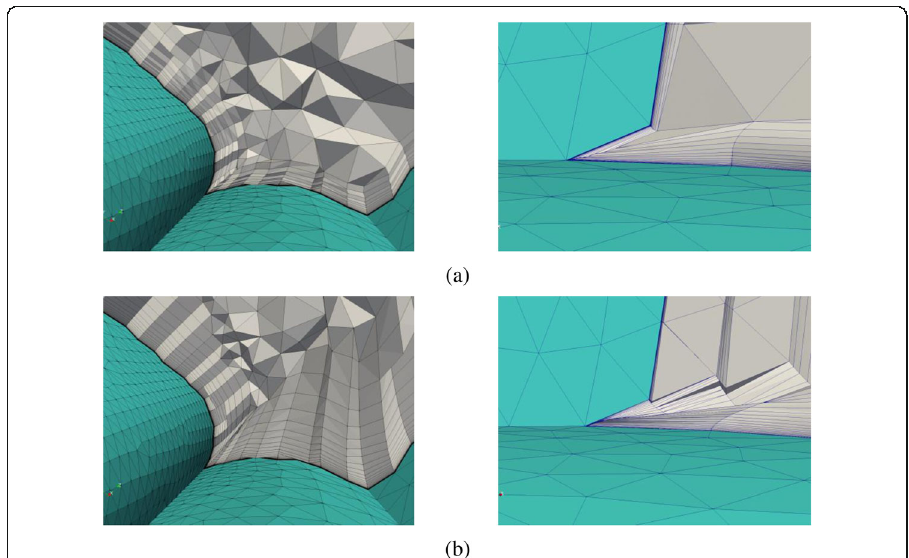
Fig. 13 Meshing results in the neighbourhood of two sharp concave angles. ( a ) Results by our algorithm. ( b ) Results by